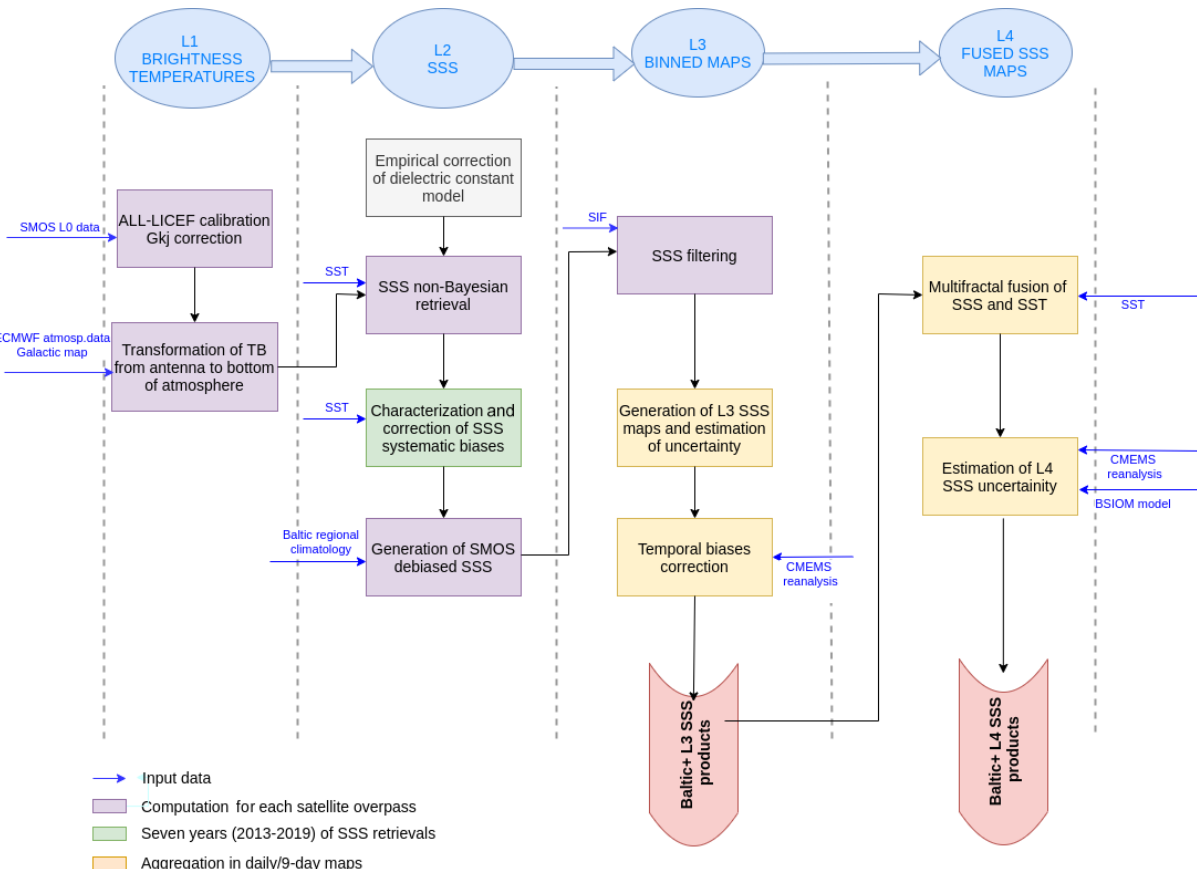
Figure 1. Block diagram of the Baltic+ SSS